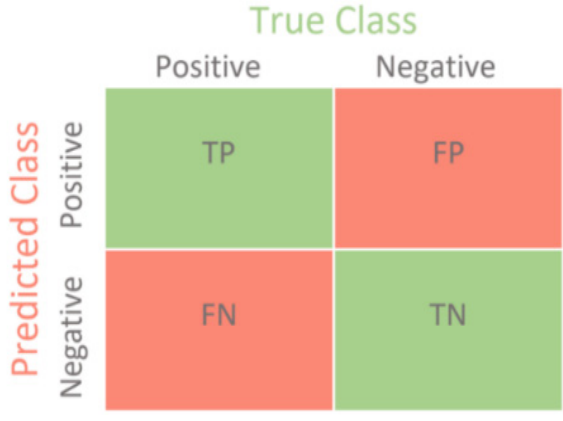
Figure 9. Confusion matrix.